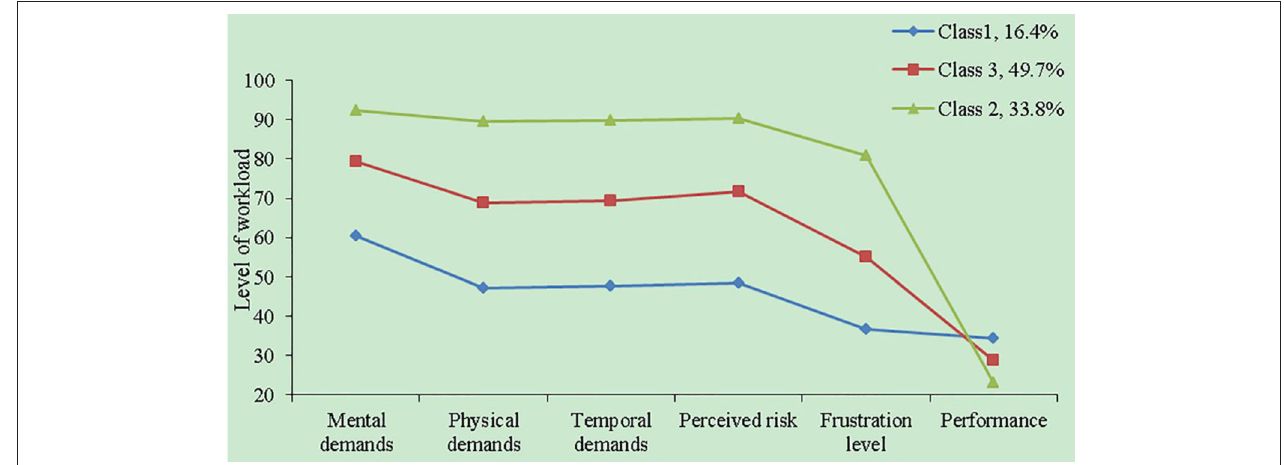
FIGURE 1 | The latent profiles of the dimensions of the Chinese version of physician mental workload scale.